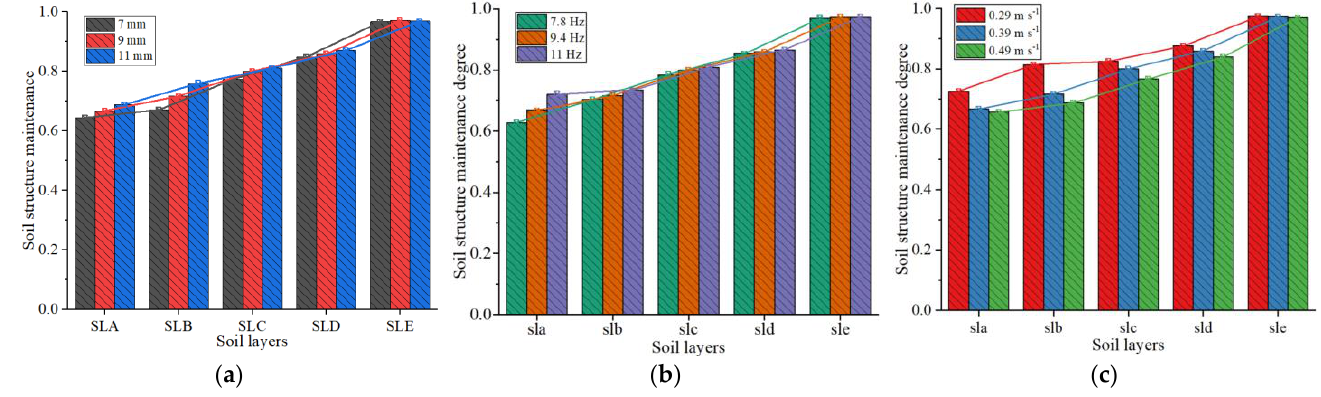
Figure 13. Effects of parameters on the soil structure maintenance degree: ( a ) Amplitude; ( b ) Vibration frequency; ( c ) Forward speed.